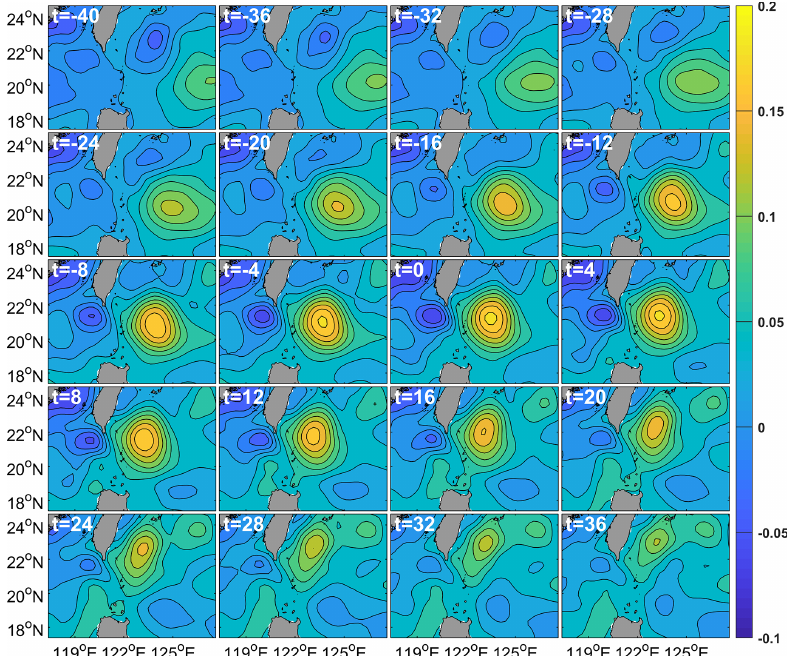
Figure 9. Evolution of AE mode of counter-rotating eddy pair in LS based on CMEMS data. Contours and shading both represent SSHA (units of m). SSHA interval is 0.02m. t in the top left-hand corner of each panel denotes days before (negative value) or after (positive value) the AE mode of counter-rotating eddy pair reached the maximum ( t = 0). t = 0 corresponds to time of Fig. 3b.